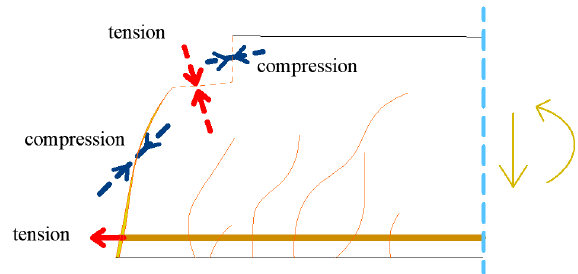
Figure 5. Potential shear transfer actions in beams without transverse reinforcement, adjusted according to [33].